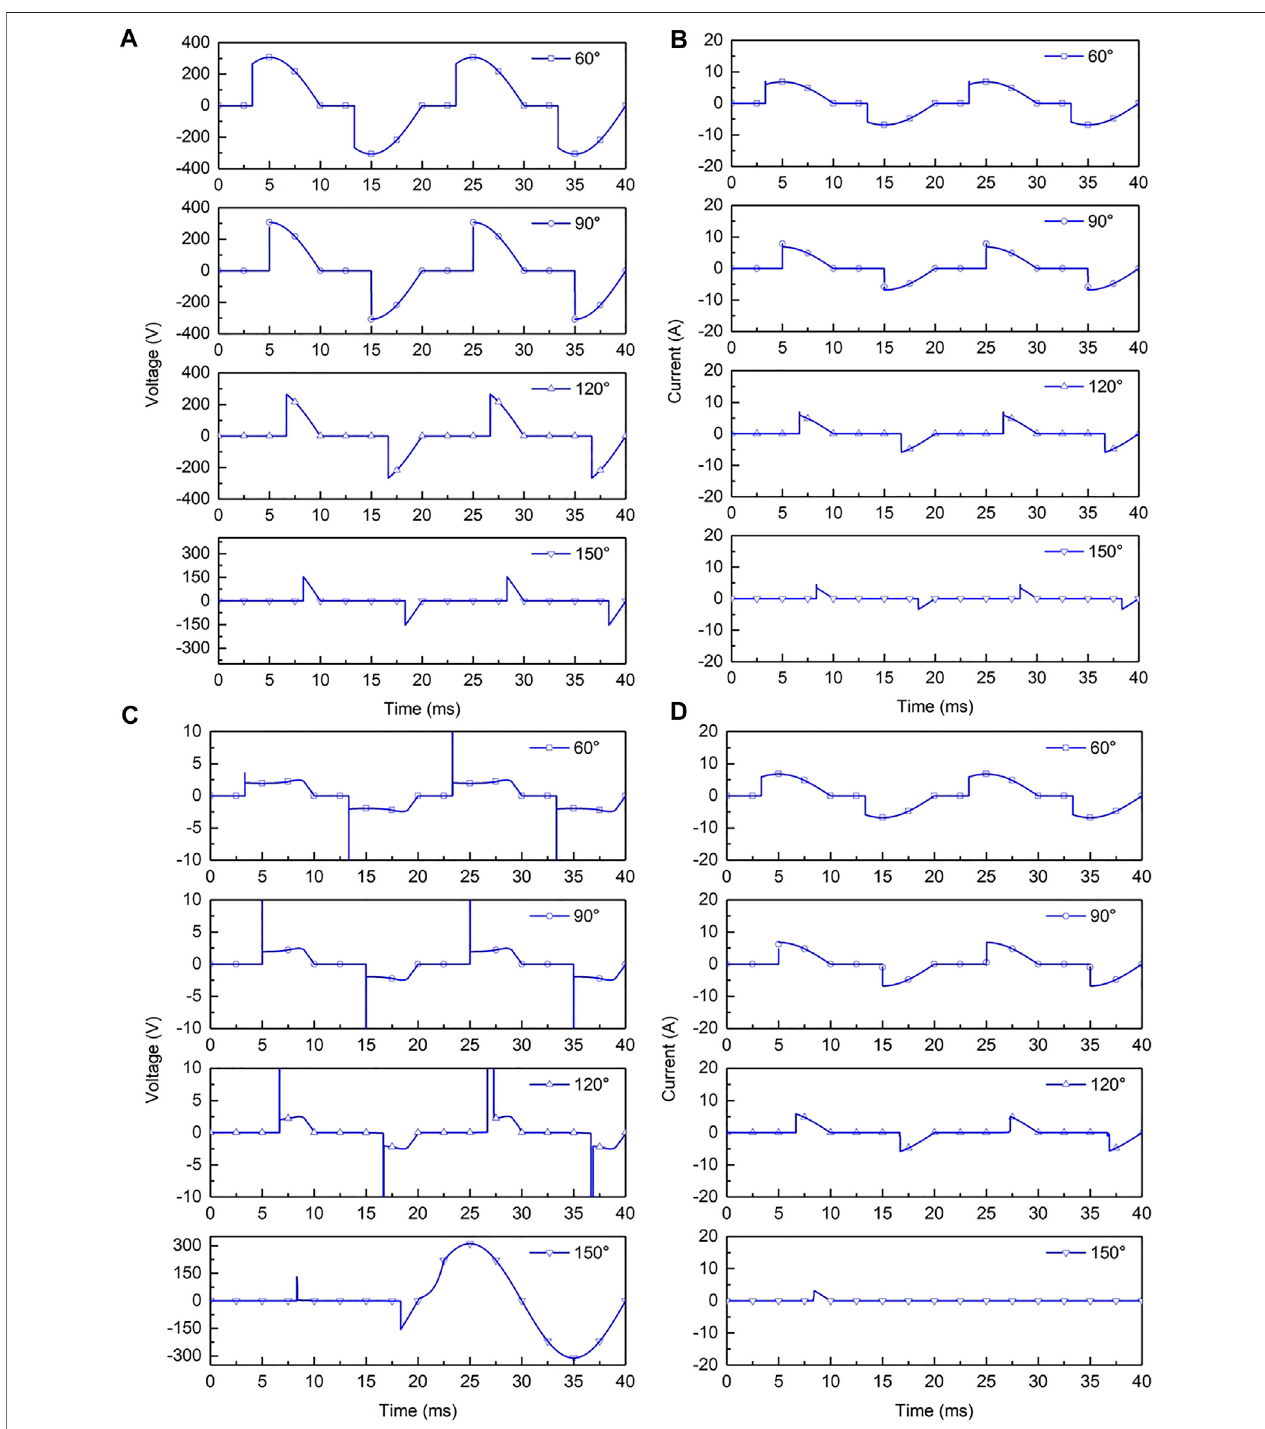
FIGURE 14 | Dimmer load (A) normal work voltage, (B) normal work current, (C) arc fault voltage, and (D) arc fault current.